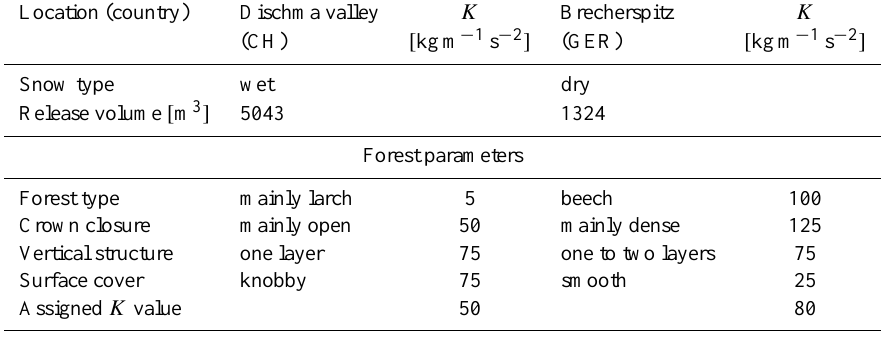
Table 3. Characteristics and K values corresponding to selected forest parameters of two avalanches which were not included in previous analyses to test the results of the operationalization.